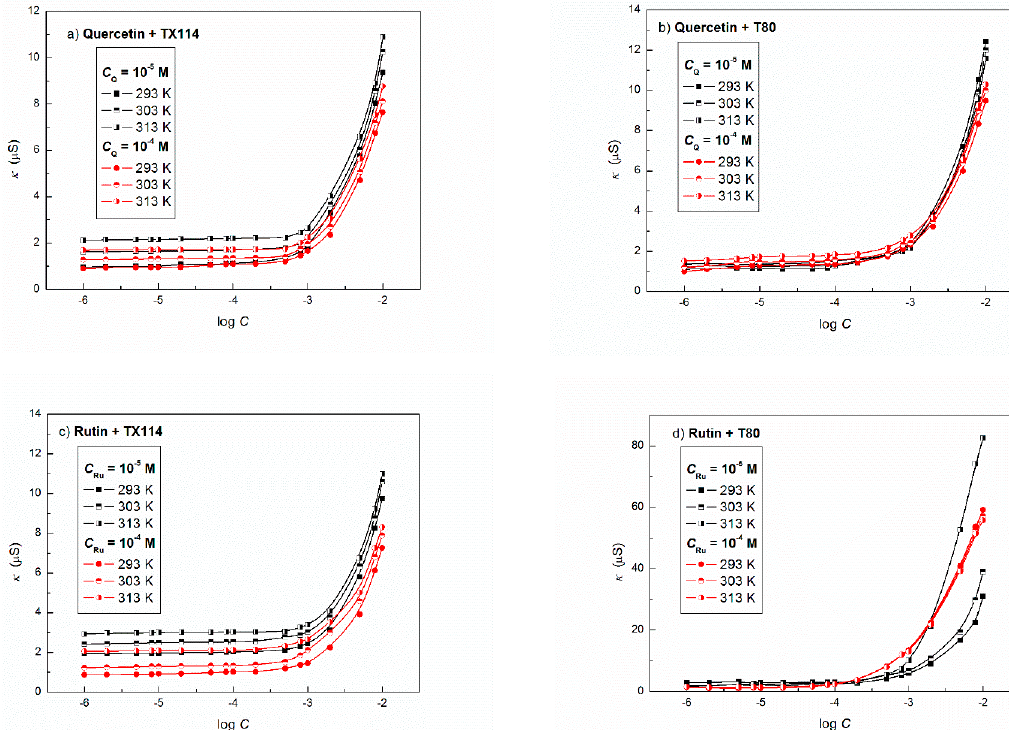
Figure 4. A plot of the specific conductivity ( κ ) of the aqueous solutions of ( a ) Q + TX114 ( C Q = 10 − 5 M and 10 − 4 M), ( b ) Q + T80 ( C Q = 10 − 5 M and 10 − 4 M), ( c ) Ru + TX114 ( C Ru = 10 − 5 M and 10 − 4 M) and ( d ) Ru + T80 ( C Ru = 10 − 5 M and 10 − 4 M) ( d ) vs. the logarithm of surfactant concentration (log C ) at different temperatures equal to 293 (curve 1), 303 (curve 2), and 313 K (curve 3), respectively.